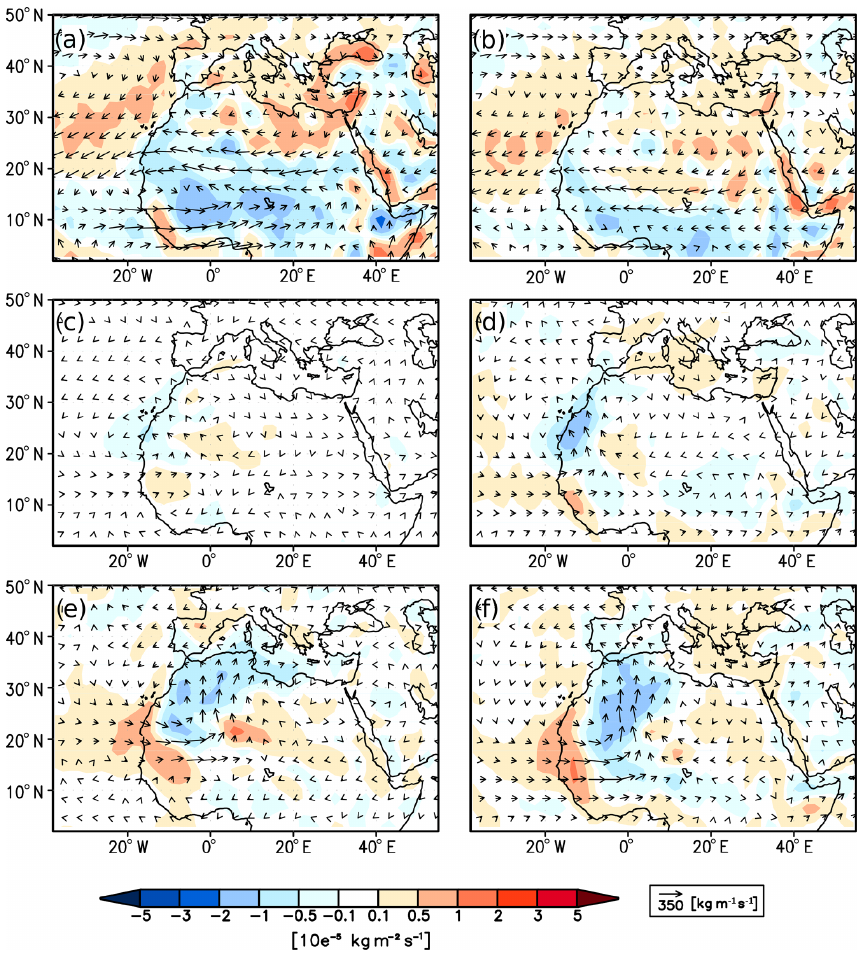
Figure 11. Monthly mean vertically integrated moisture flux (vectors, kgm − 1 s − 1 ) and its convergence (shaded, convergence is blue, divergence is red, 10 × 10 − 5 kgm − 2 s − 1 ) for (a) 7ka September and (b) 7ka October (both months have been adjusted to the fixed-angular calendar); (c, d) differences in vertically integrated moisture flux and its convergence between the composite of all rain events occurring in the coastal area (15–11 ◦ W, 20–25 ◦ N) and the monthly mean flow for (c) 7ka September, (d) 7ka October; and (e, f) the differences between the composite of all rain events in the western Sahara (20–35 ◦ N, 10 ◦ W–10 ◦ E) and the monthly mean flow for (e) 7ka September and (f) 7ka October. To convert the convergence in units of millimetre per day (mmd − 1 ), please multiply by 86400sd − 1